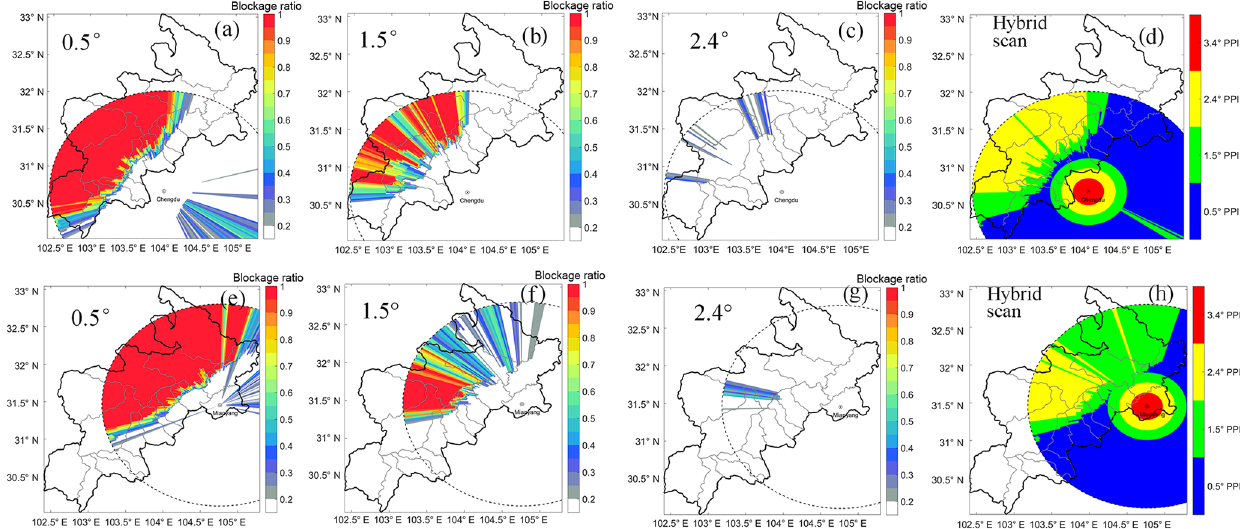
Figure 4. Blockage ratio of beam shielding for the radar main lobe beam and hybrid scan map. Panels (a) – (c) represent the blockage ratio of Chengdu radar at elevations of 0.5, 1.5 and 2.4 ◦ , respectively. Panels (e) – (g) represent the blockage ratio of Mianyang radar at elevations of 0.5, 1.5 and 2.4 ◦ , respectively. Hybrid scan maps for Chengdu (d) and Mianyang (h) are merged as long as the blockage ratio is lower than